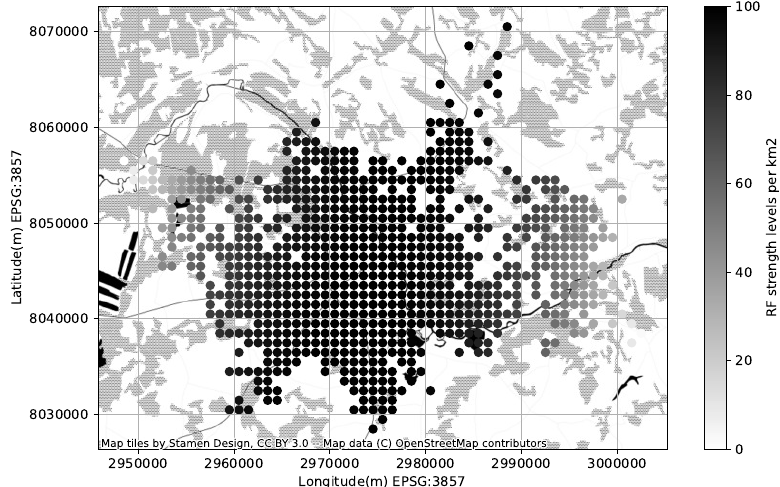
Figure 6. RF signal strength distribution per square